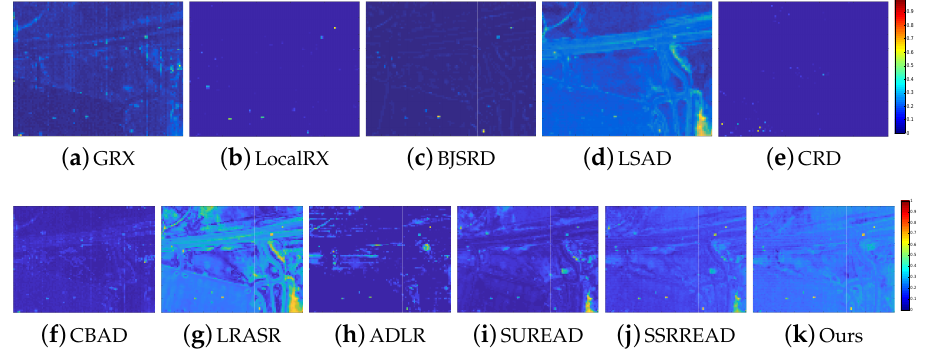
Figure 10. 2-D target probability color maps of the detection algorithms for the Urban dataset.